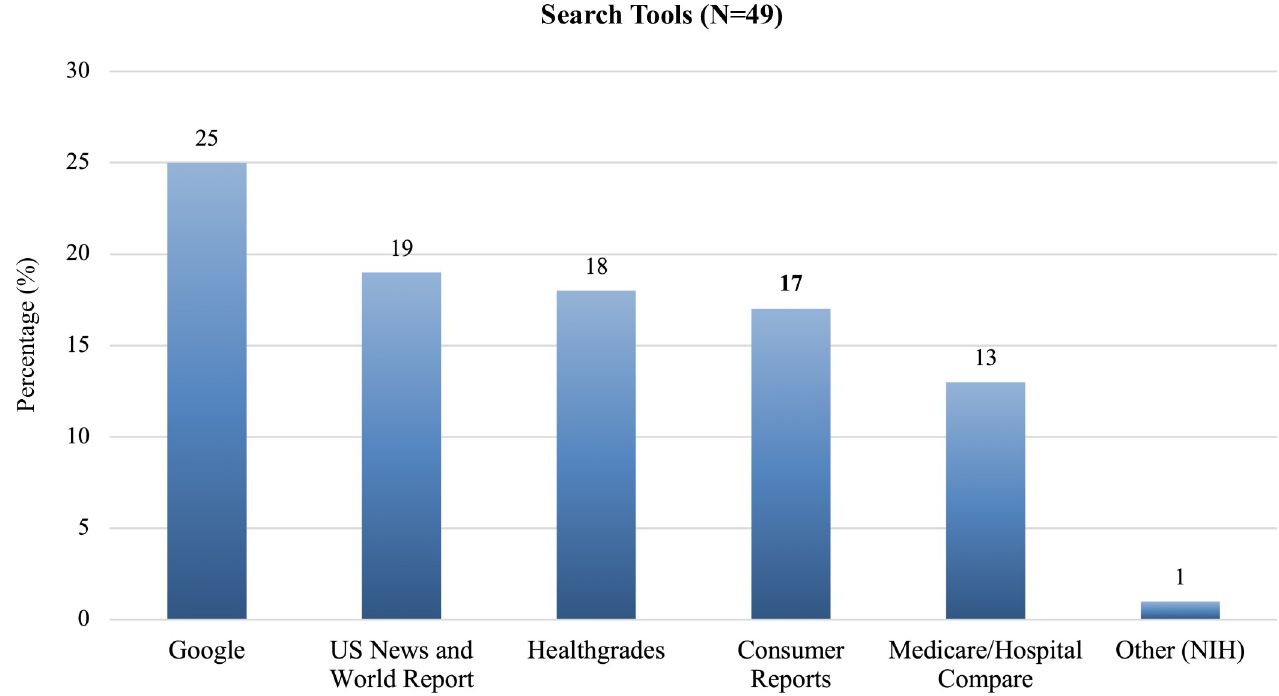
Fig 5. Search tools (%). Frequency of search engine tools (N = 49). Twenty-five patients chose more than one tool.